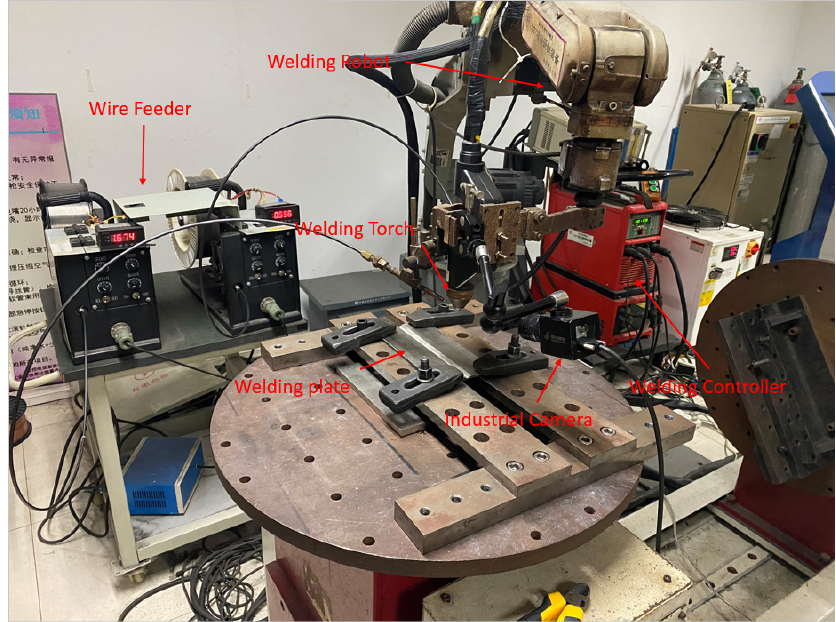
Figure 2. Welding system.